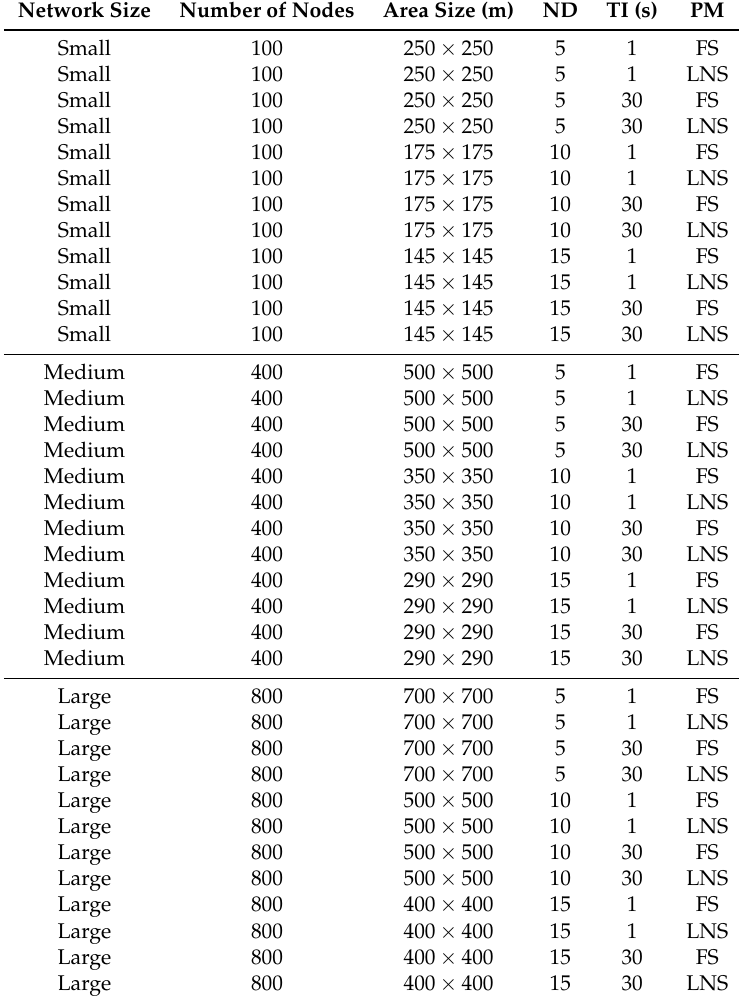
Table 2. Simulation scenarios for mDaral . ND, TI and PM stand for Node Density, Time Interval and Propagation Model